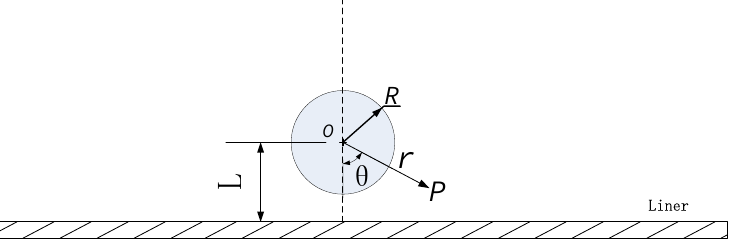
Figure 1. Sketch of bubble model near solid